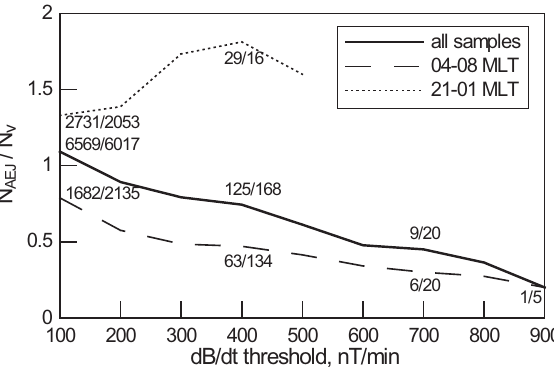
Fig. 5. Ratio of the number of electrojet-dominated samples ( N AEJ ) to the number of vortex-dominated samples ( N V ) as a function of dB/dt threshold. Statistics for morningside and pre-midnight sam- ples is also shown by dashed and dotted lines, respectively, the N AEJ and N V numbers are explicitly shown for some thresholds to illustrate the statistics